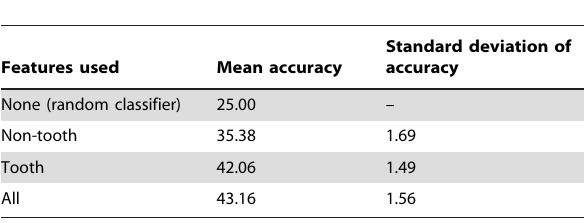
Table 4. Species identification using multi-class